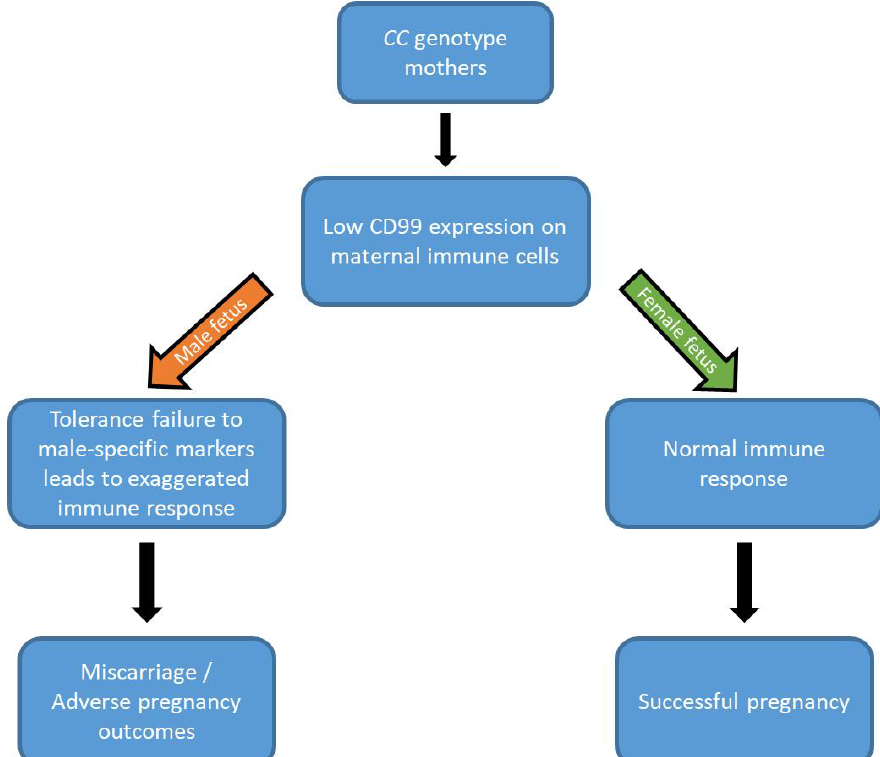
Figure 1. Adverse pregnancy outcomes in male pregnancy. In CC mothers, low CD99 expression may have an effect on pregnancy outcome in a fetal sex-dependent manner. In the case of a male fetus, the maternal immune tolerance is abnormal and the pregnancy outcome is more likely to be adverse, whereas in the case of a female fetus, the maternal immune tolerance is normal, and the pregnancy is more likely to be successful.